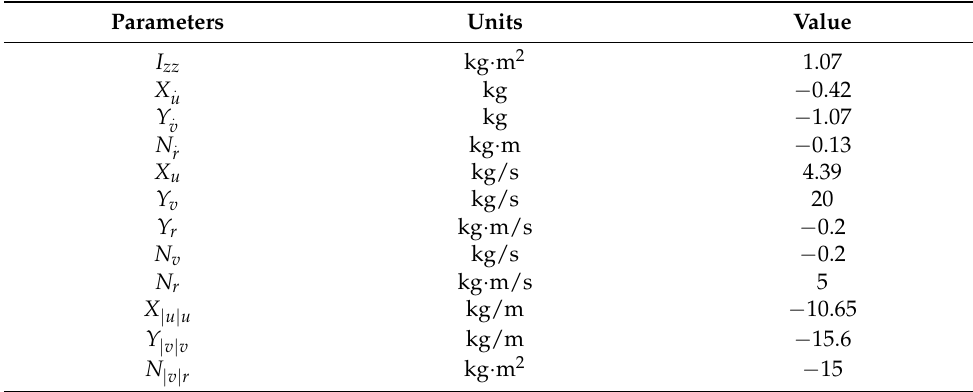
Figure 2. USV experimental platform. Table 1. USV-related kinetic parameters.